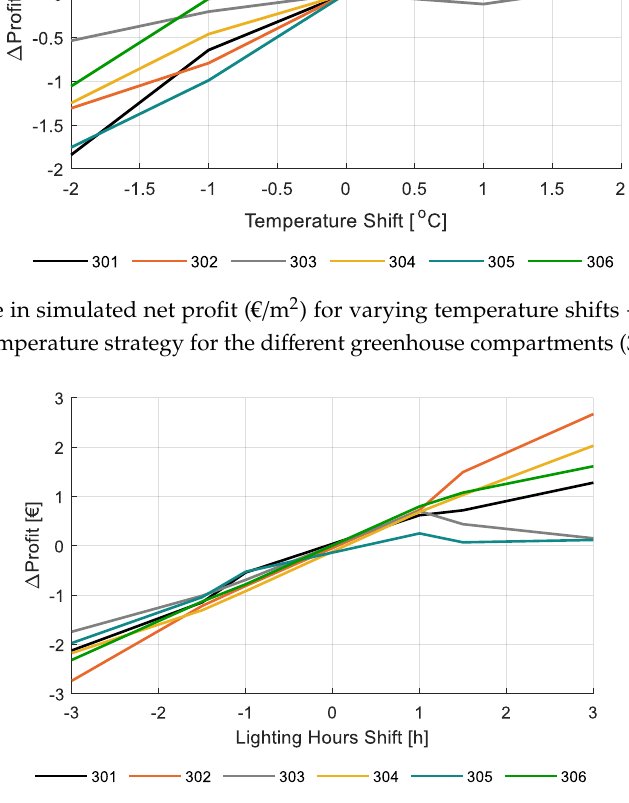
Figure 21. Change in simulated net profit (€/m2) for varying the daily lighting hours −3 to +3 h on top of the realized illumination strategy for the different greenhouse compartments (301–306).